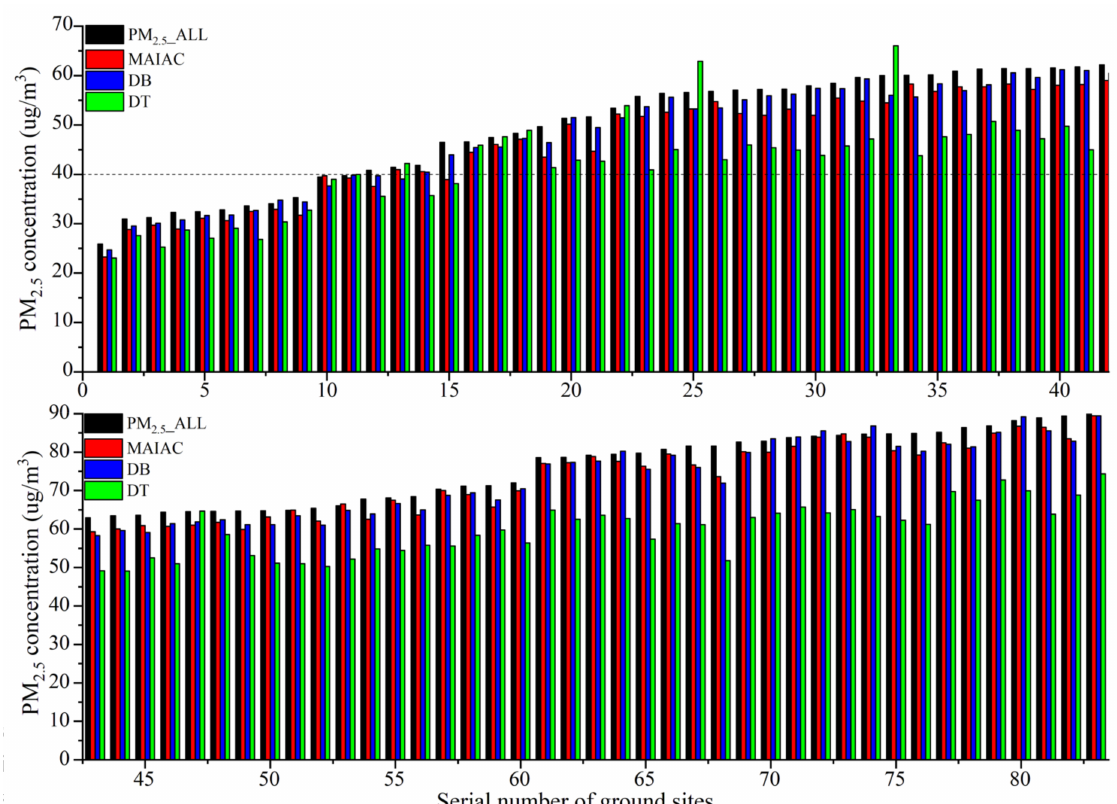
Figure 8. The annual mean PM 2.5 values in the 83 sites for all the measurements (PM 2.5 _ALL) and those matched with MAIAC, DB, and DT AOD, respectively. The number of ground sites is sequenced by annual PM 2.5 concentration of ground measurements. Site 1–42 is at the top, and 43–83 is at the